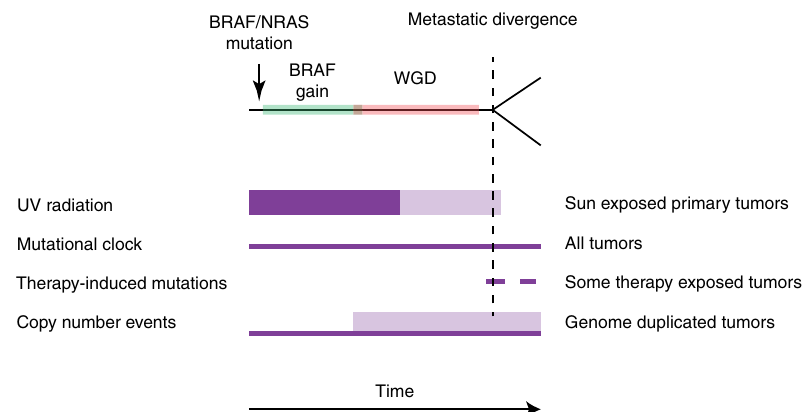
Fig. 6 Model of progression for metastatic melanoma. Purple fi elds portray the timing of mutational processes, with increased thickness indicating higher mutational activity. Lower opacity indicates variability in timing of processes in relation to each other; e.g., timing of UV radiation in relation to the timing